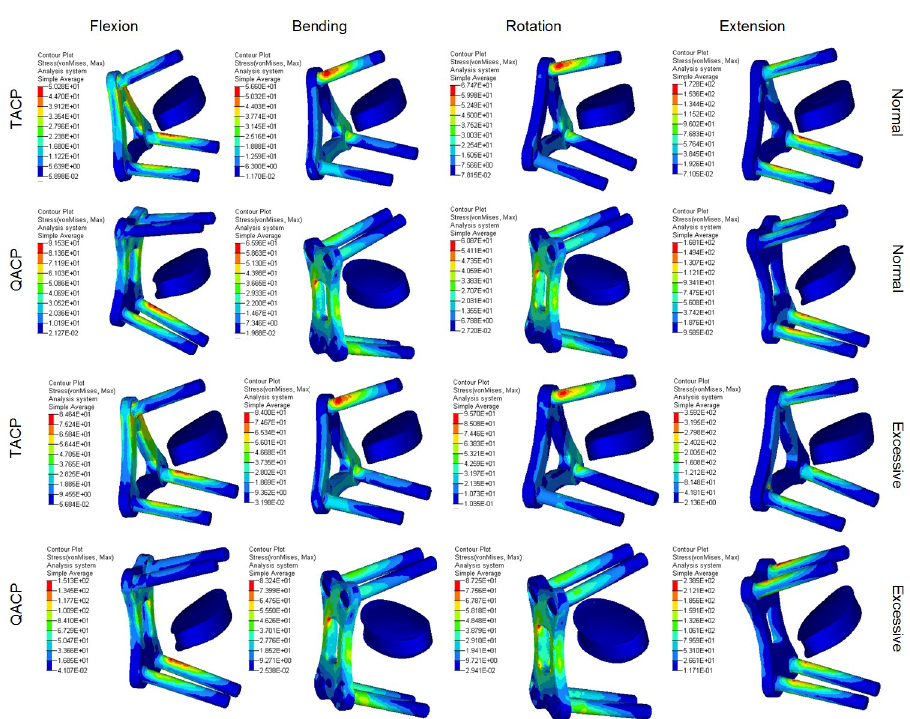
Fig 3. Von-mises equivalent stress cloud diagram examining differences in TACP and QACP surgical outcomes under varying motion conditions. Normal refers to normal postoperative motion, and Excessive refers to excessive postoperative